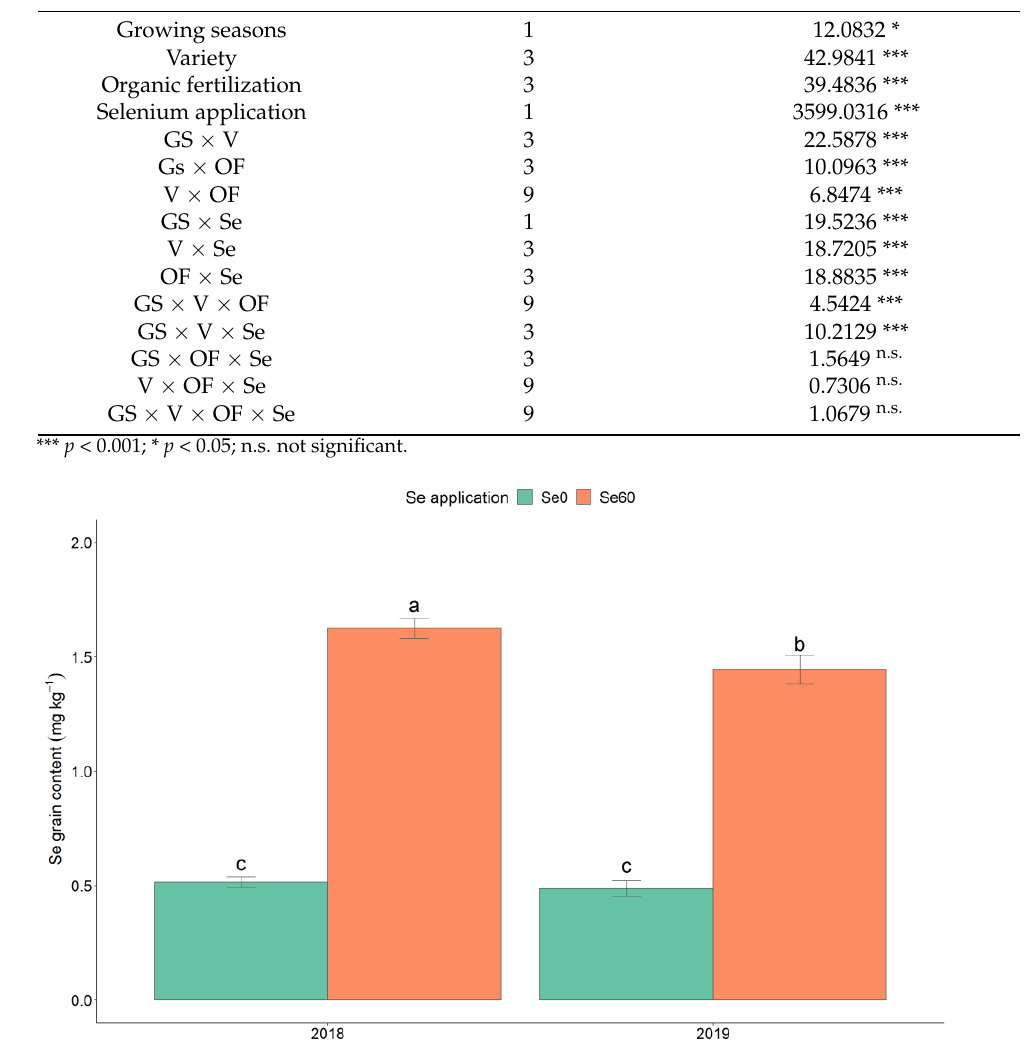
Figure 2. Effect of interaction growing season × selenium application on Se content in grain. Se0, no selenium application; Se60, selenium application. Tukey HSD significant differences ( p < 0.05) are indicated by different letters. Vertical bars indicate standard errors (n = 48).